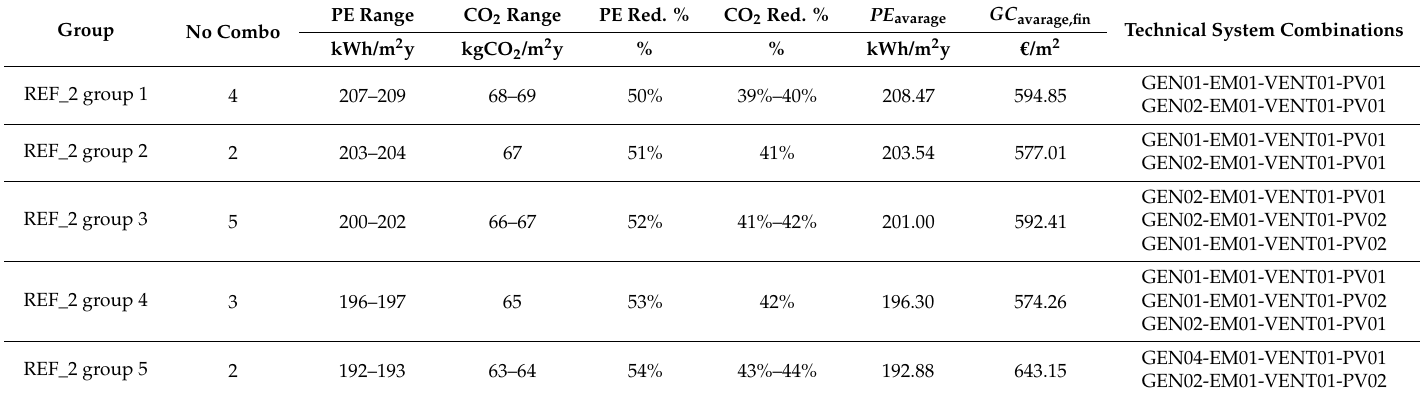
Table 7. Range of primary energy consumptions and global costs of combinations for